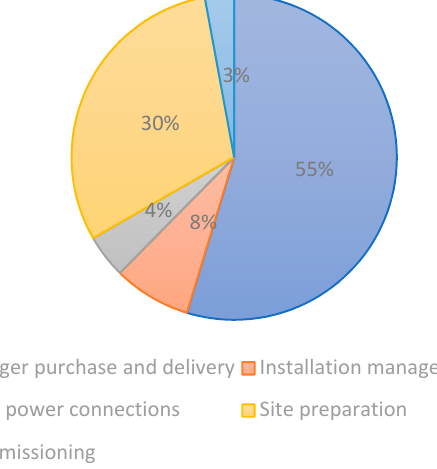
Figure 6. Cost breakdown as a percentage of the total CAPEX in all sites [2].